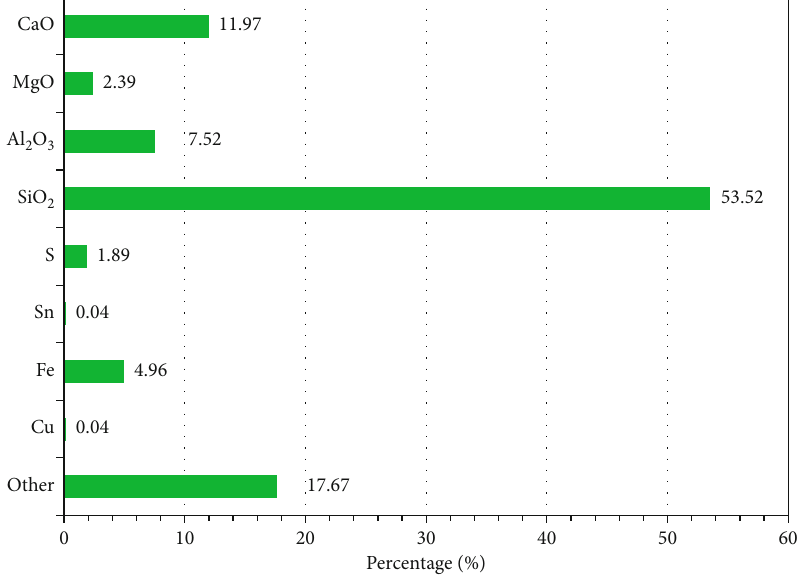
Figure 2: Chemical composition of tailing. Table 1: Physical properties of the fi lling material.